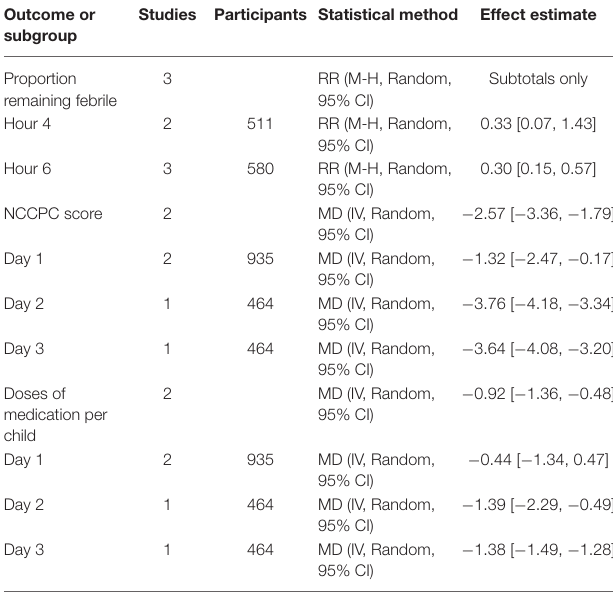
TABLE 4 | Comparison 2: alternating therapy vs. single